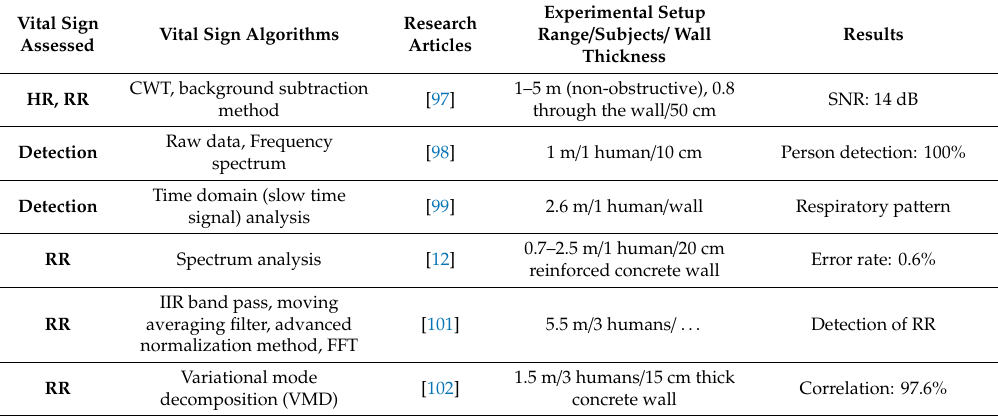
Table 5. Performance comparison of vital sign detection algorithms for through-wall